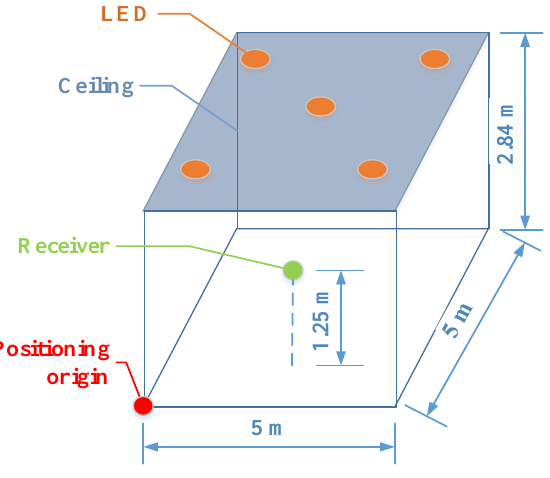
Figure. 2. Experiment Setup. Figure 2. Experiment